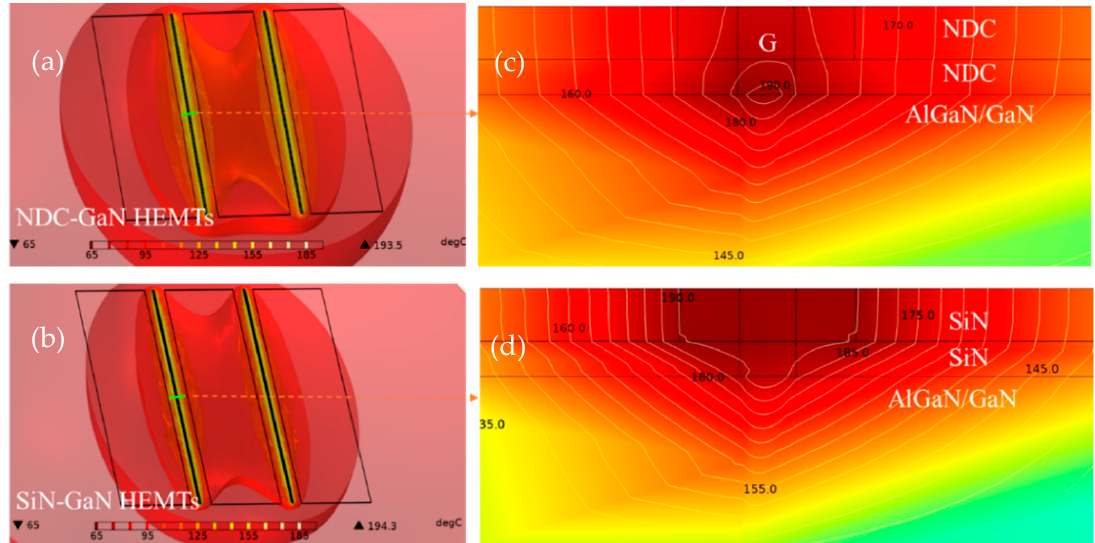
Figure 9. The temperature distribution and junction temperature of GaN HEMTs with NDC ( a ) and SiN ( b ) passivated structures of thermal simulation calculations; the temperature gradient around heat source regions (the center regions of gate) of GaN HEMTs with NDC ( c ) and SiN ( d ) passivated structures.